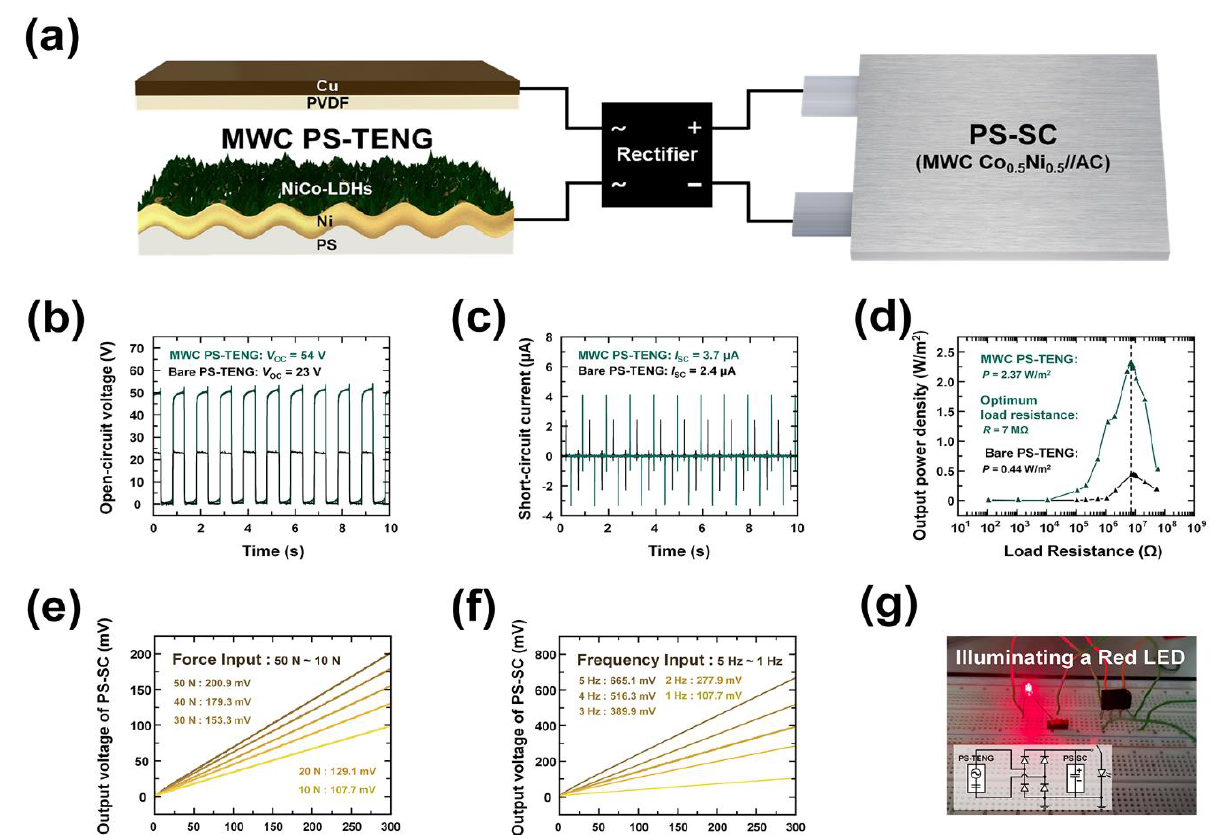
Figure 7. Triboelectric-driven self-charging HSC power cells composed of as-fabricated MWC PS- TENG and PS-SC. ( a ) Schematic circuit diagram of integrated energy system. Electrical output performance for comparison of bare PS-TENG and MWC PS-TENG; ( b ) open-circuit voltage ( V oc ), ( c ) short-circuit current ( I sc ), and ( d ) output power density for the dependence of the load resistance. The charging efficiency under ( e ) various input forces (from 10 to 50 N), and ( f ) input frequencies (from 1 to 5 Hz) of MWC PS-TENG. ( g ) Demonstration of feasible application by lighting up a commercial LED (in inset image of circuit diagram).